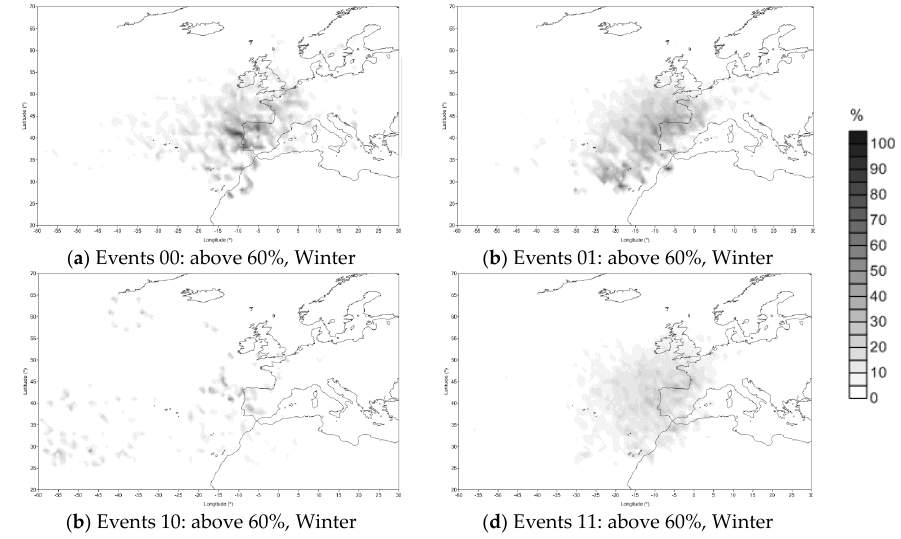
Figure 3. Composite analysis for Methodology 1 for Winter months with a power production higher than 60% over the installed capacity: ( a ) 00 events; ( b ) 01 events; ( c ) 10 events; ( d ) 11 events. The TC values are 36, 73, 50 and 205 for Events 00, 01, 10 and 11, respectively. Table 3. TC values and frequency of occurrence (%) for each class of event identified in Met. 1 for Winter months. Class TC Frequency of Occurrence (%)